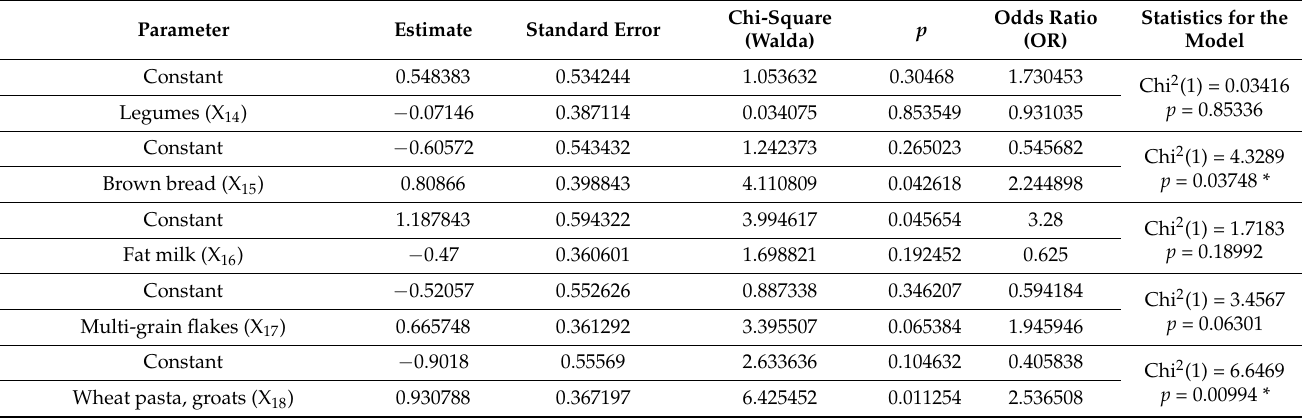
Table 12. Logistic regression score (LRS)—assessment of the relationship between selected food products considered individually and the probability of an increased level of homocysteine for the CA group.